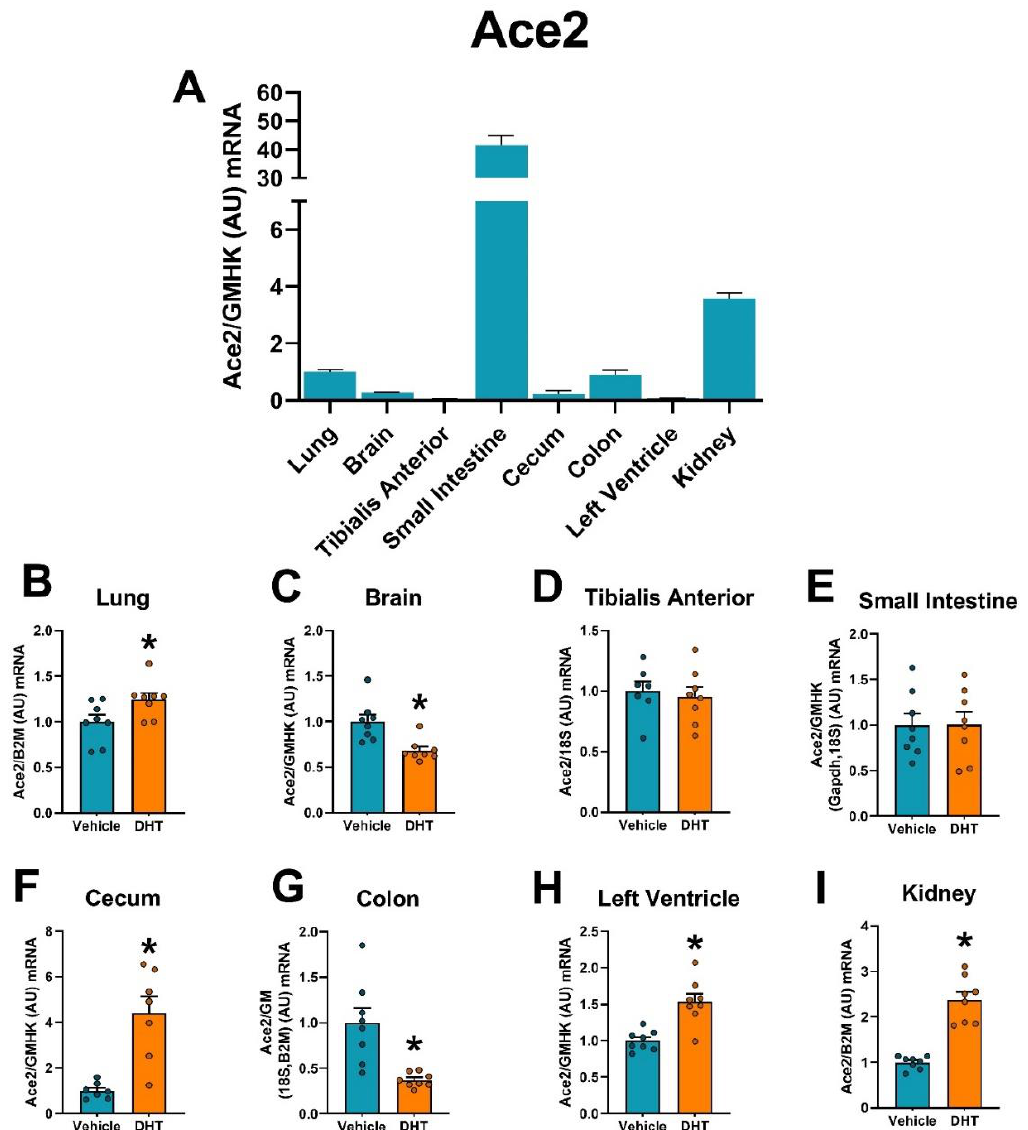
Figure 3. Ace2 mRNA expression regulation by DHT in different tissues. Ace2 mRNA expression was quantified by RT- qPCR. ( A ) Ace2 mRNA expression in control mice normalized to the geometric mean of all reference genes and expressed relative to lung tissue. ( B – I ) Ace2 mRNA expression in the lung ( B ), brain ( C ), tibialis anterior ( D ), small intestine ( E ), cecum ( F ), colon ( G ), left ventricle ( H ), and kidney ( I ) of control and DHT-treated mice normalized to the least variable reference gene or set of them and expressed relative to control mice. Data analyzed by t-test. n = 7 – 8/group. *: p <0.05.